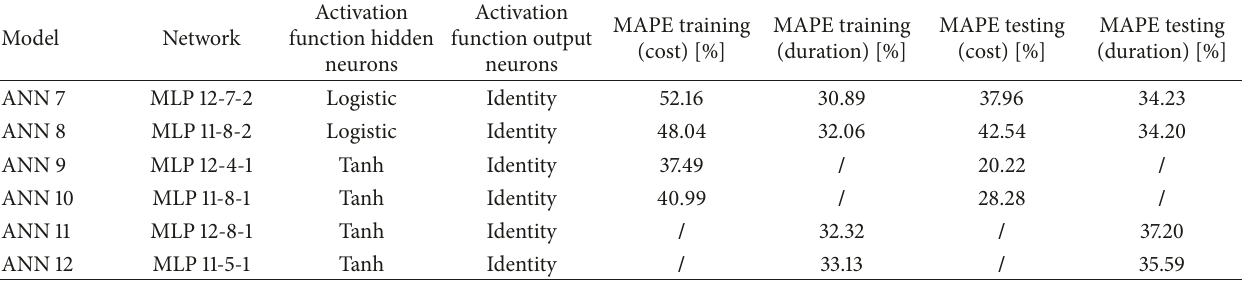
Table 8: ANN models